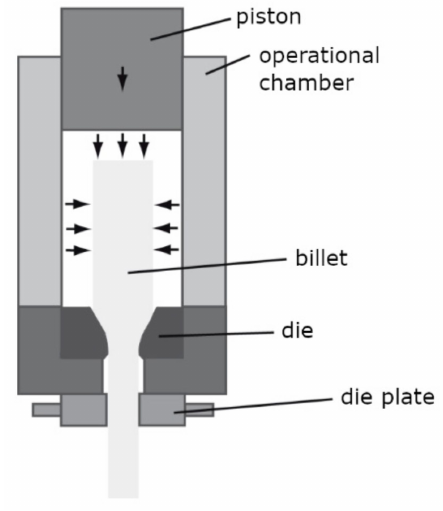
Figure 1. The scheme of hydrostatic extrusion